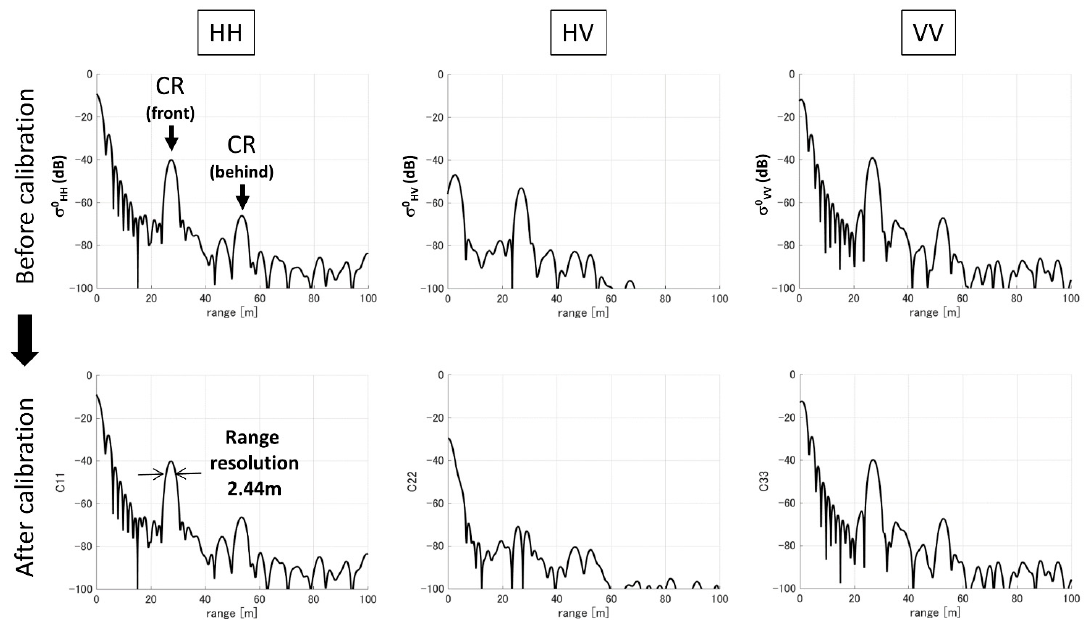
Figure 5. GB-radar range profiles before and after calibration.